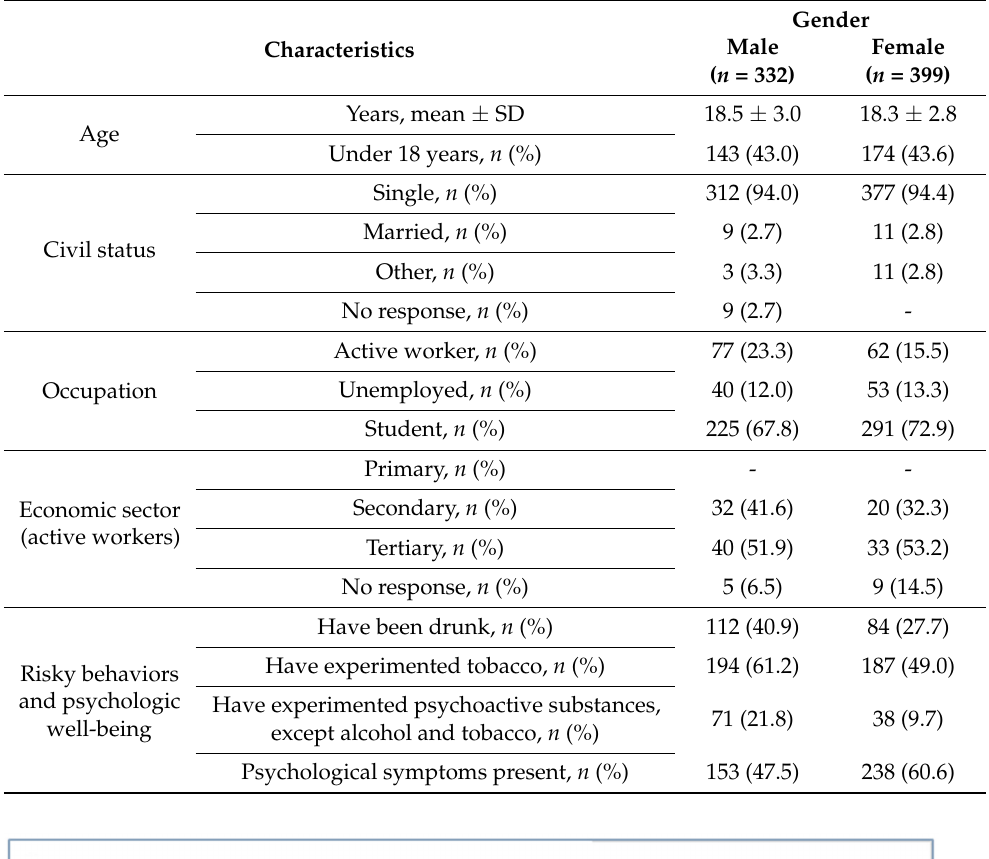
Table 1. Sociodemographic characteristics by gender.